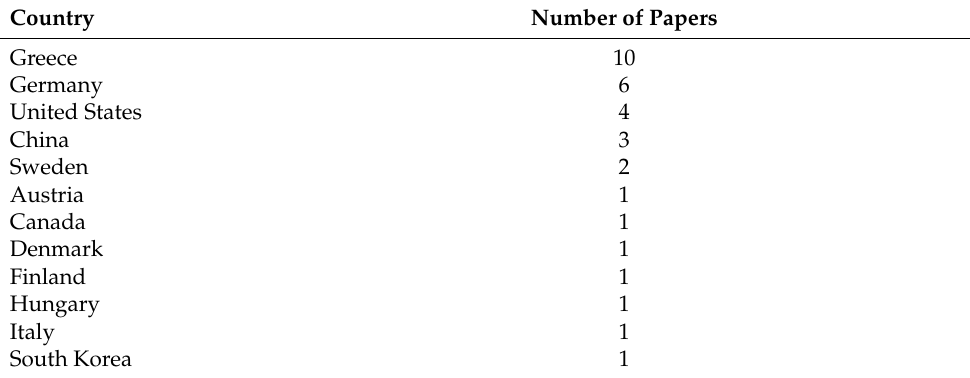
Table 11. Number of Papers by county.